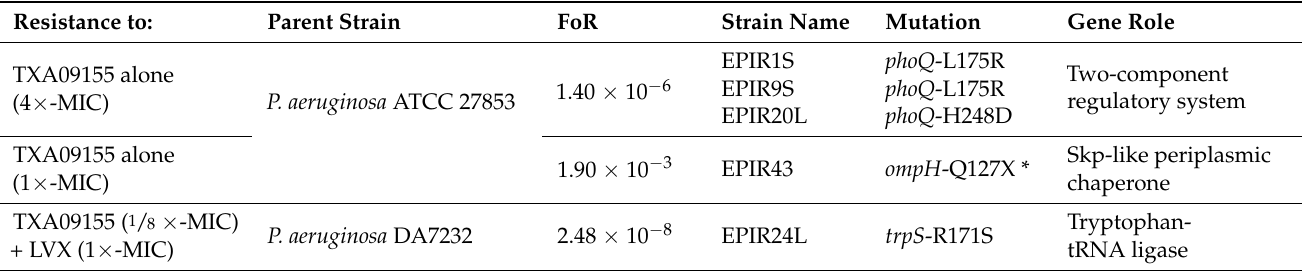
Table 5. Genetic study of TXA09155 resistance in P. aeruginosa